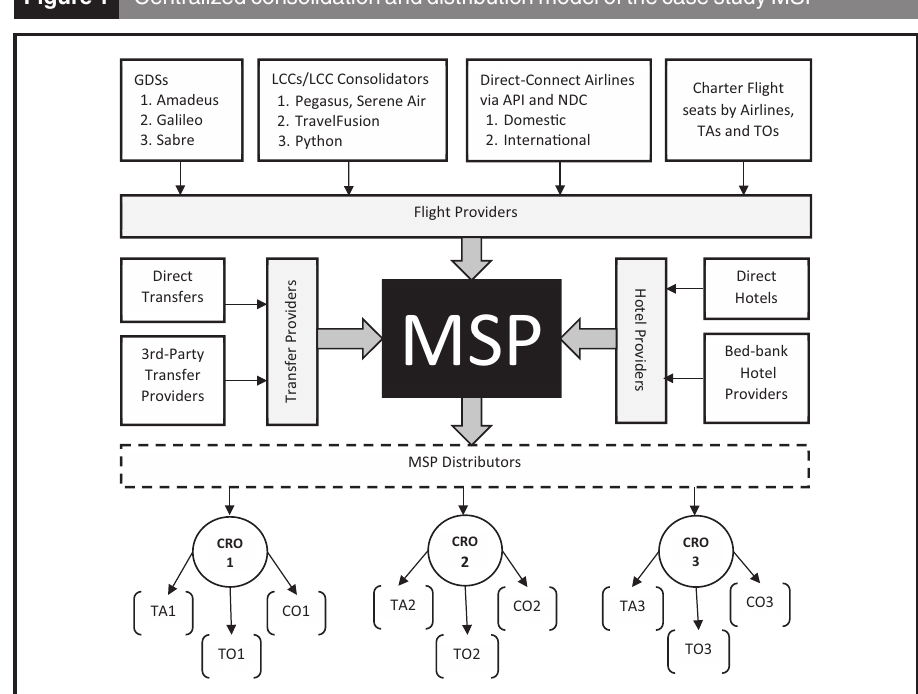
Figure 1 Centralized consolidation and distribution model of the case study